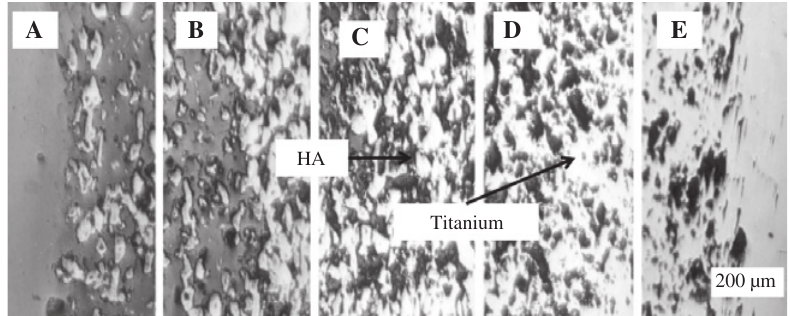
Figure 6: Microstructure of a cross section of HA-Ti FGM having a continuous composition gradient where TI percentage continuously increases from (A) to (E) [35].